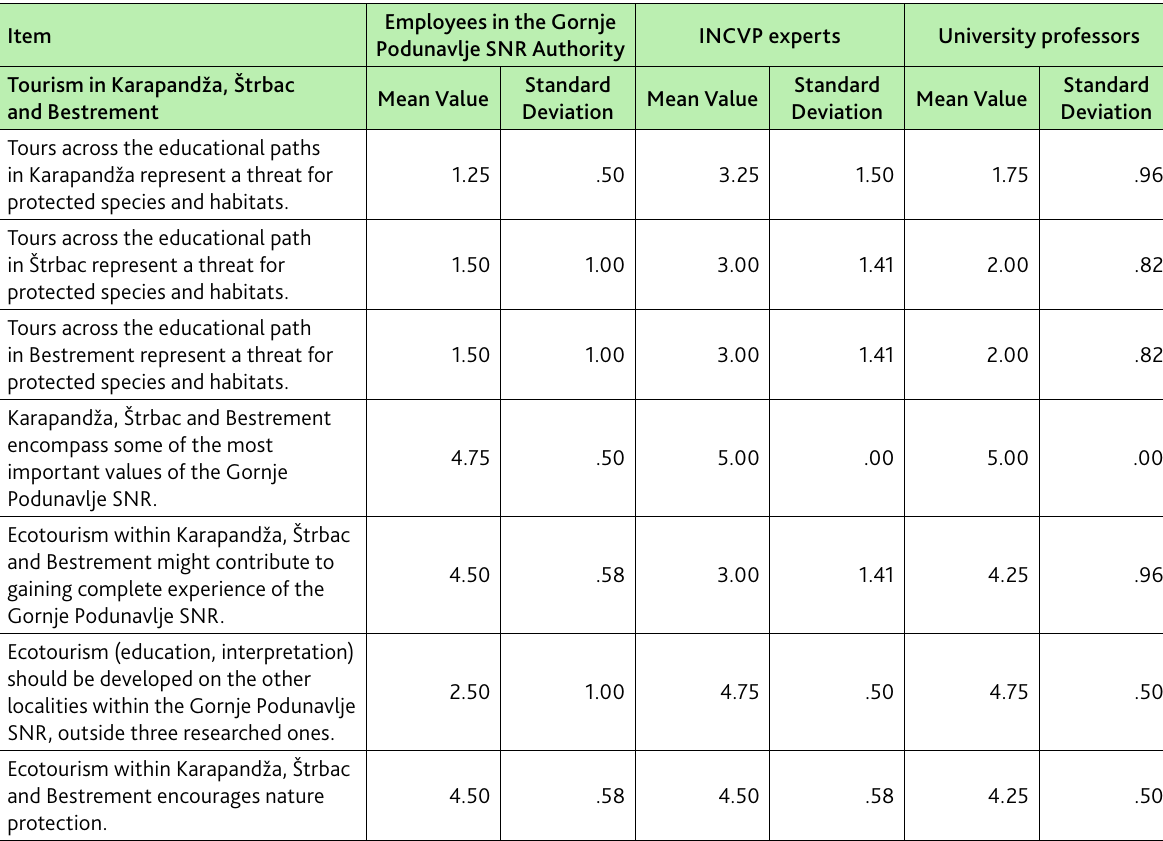
Table 3. Respondents’ attitudes on ecotourism in Karapandža, Štrbac and Bestrement